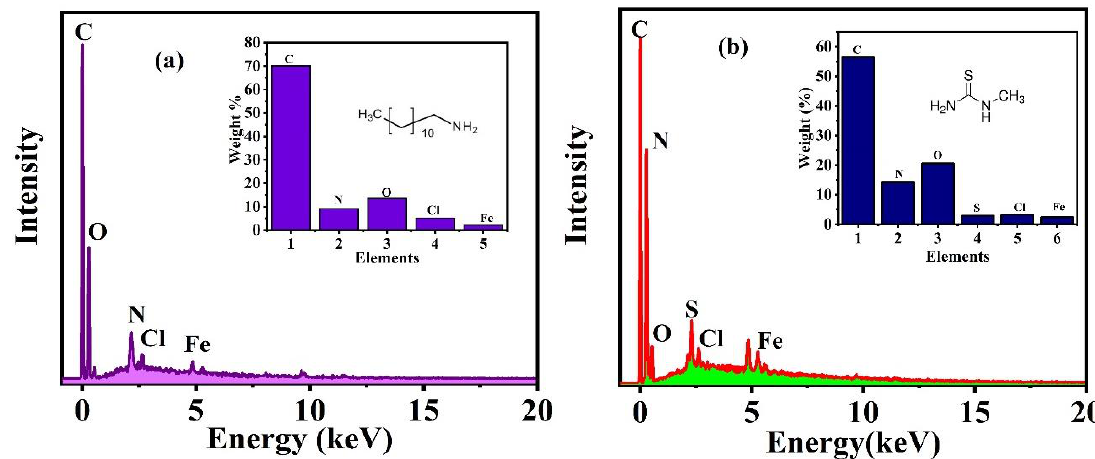
Figure 11. EDX analysis of the protective film formed on the scratched area of the reinforced epoxy coated samples with ( a ) CeO 2 / DDA ( b ) CeO 2 / NMTU.